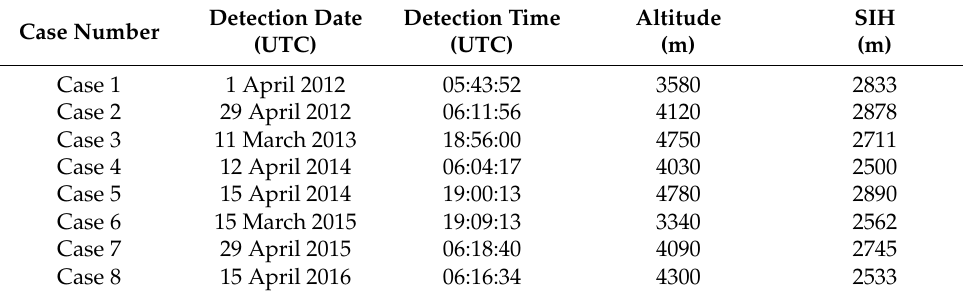
Table 2. Eight cases of forest and grassland fire SIHs derived from